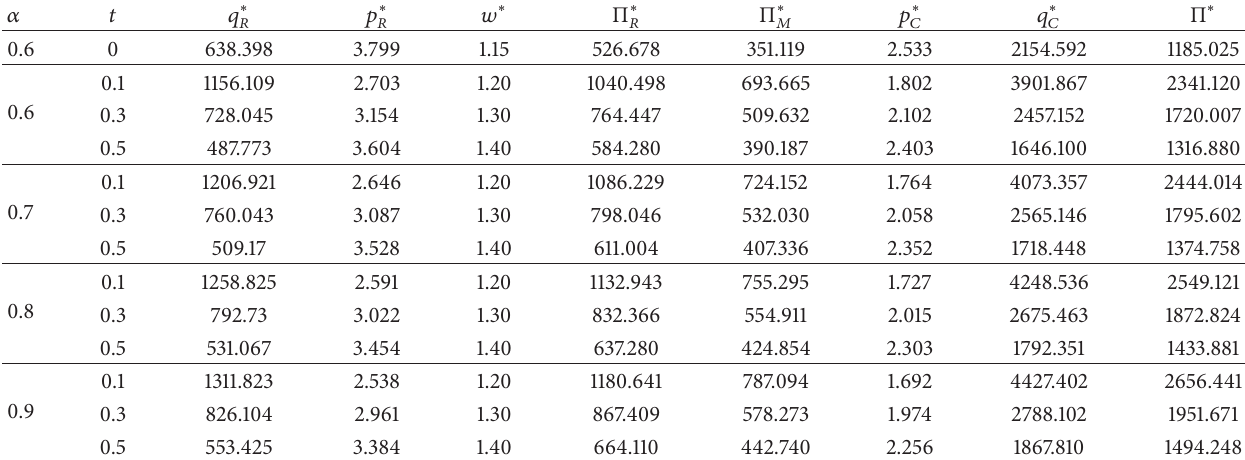
Table 4: The optimal decisions and profits with varying 𝛼 and 𝑡 .